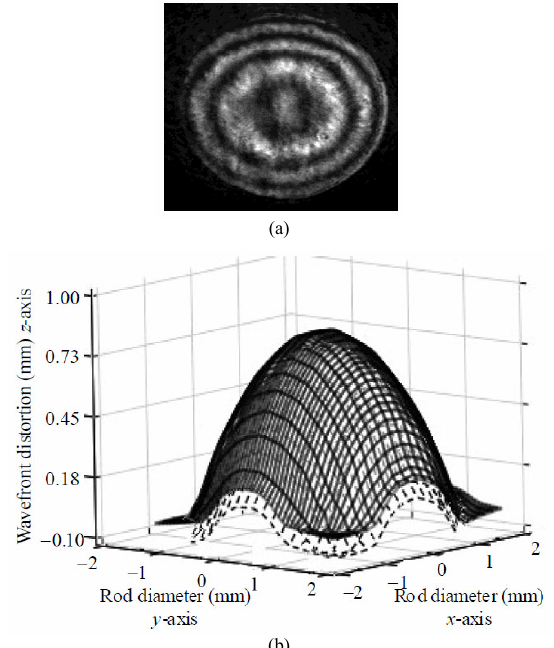
(b) Fig. 8 Deformation in wavefront of He-Ne laser beam after passing through pumped Nd: YLF laser rod at 15 W measured with (a) Mach-Zehnder interferometer and (b) Shack-Hartmann sensor (solid lines), the fitting is represented by he dashed lines.